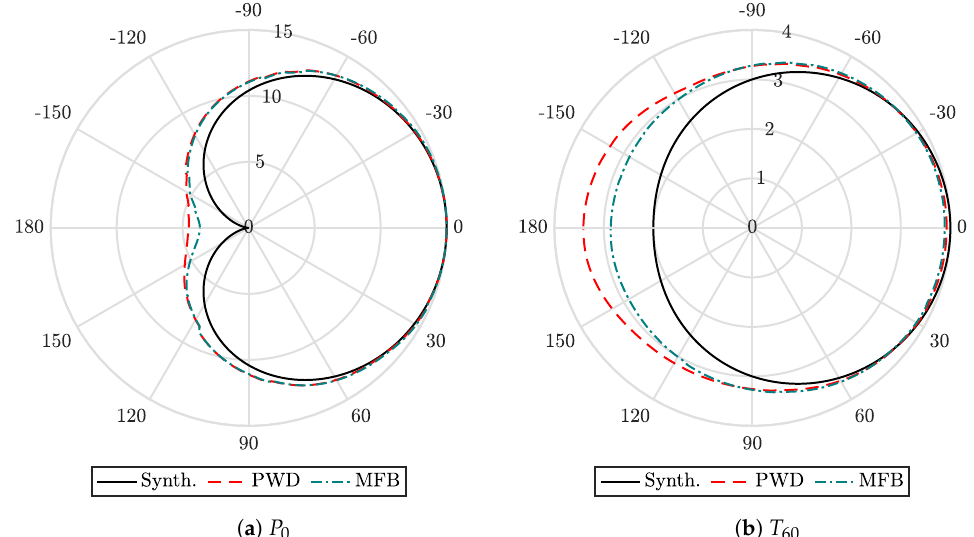
Figure 6. Comparison of broadband EDR analysis results for ( a ) the initial spectrum P 0 and ( b ) the reverberation time T 60 , between “natural” 4th-order PWD beamforming weights (red dashed lines), 4th-order maximum front-to-back ratio beamforming (MFB, green dash-dot lines), and the synthesized cardioid distributions (black solid lines). Radii represent ( a ) dB and ( b )